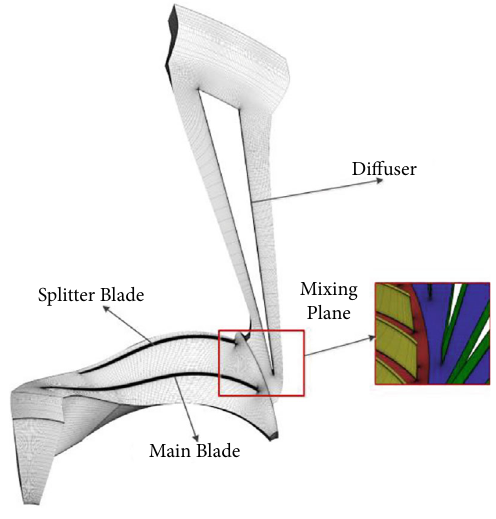
Figure 2: Computational grid of NASA DDA 404-III centrifugal compressor. Table 4: Mesh overview.